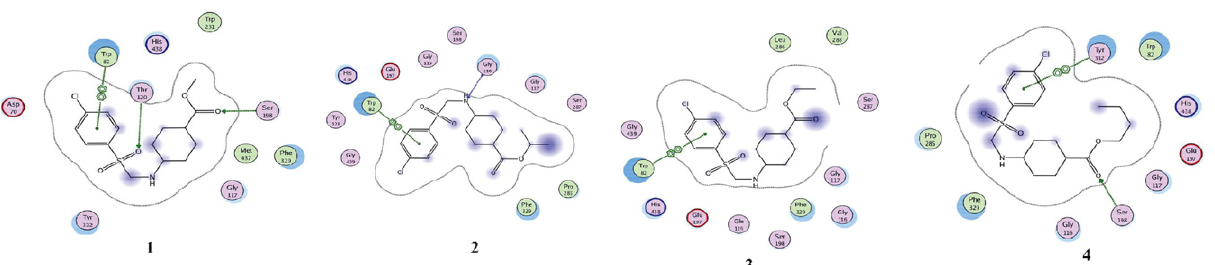
Figure 5. Interactions of synthesized esters with BChE